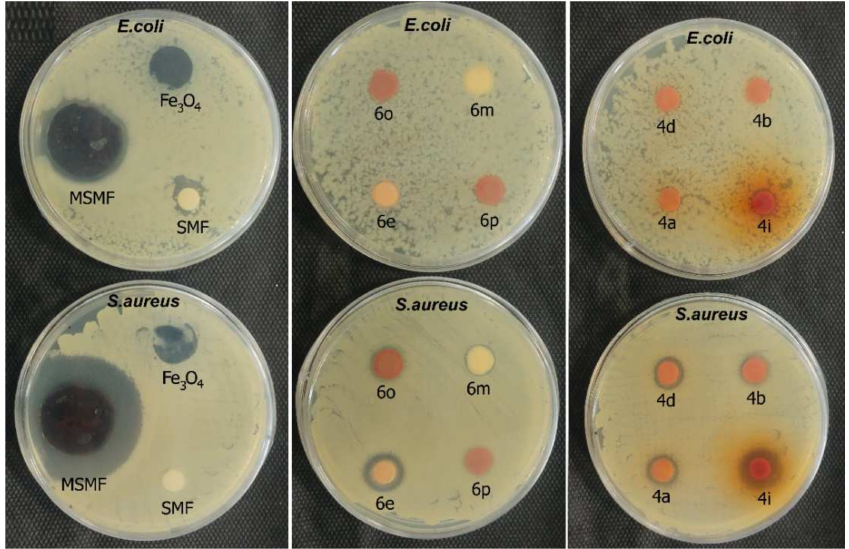
Figure 10. Antibacterial activities of SMF, MSMF, some benzyl pyrazolyl naphthoquinone, and 4- [(indol-3-yl)-arylmethyl]-1-phenyl-3-methyl-5-pyrazolones against Escherichia coli and Staphylococcus aureus via Kirby–Bauer disk diffusion technique. Table 7. Antibacterial activities of catalysts and some benzyl pyrazolyl naphthoquinone, and